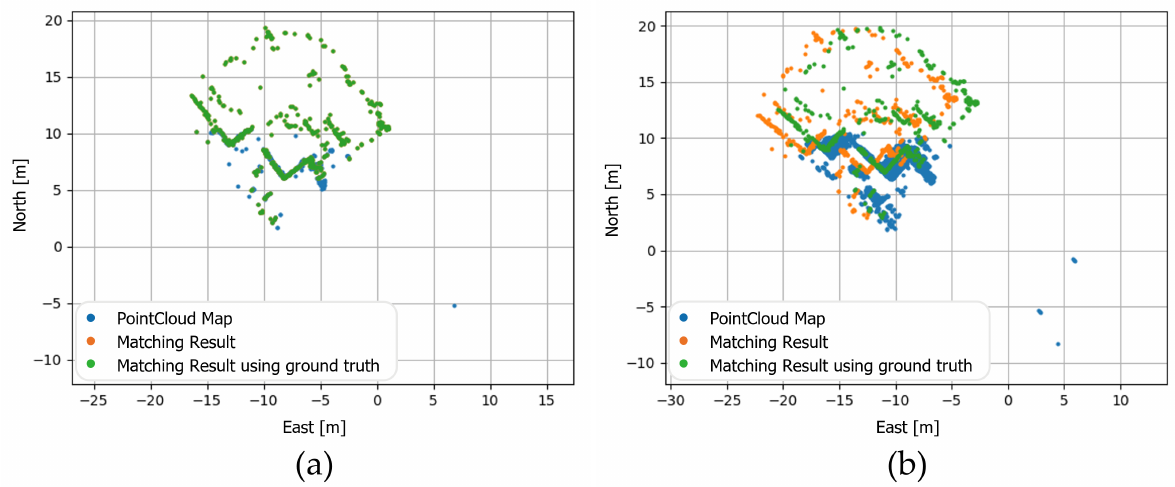
Figure 4. ( a ) Result of matching between PCM and point cloud using the good calibration parameter; ( b ) result of matching using the wrong calibration parameter; blue points represent PCM on world coordinate, orange points represent matched points using registration, and green points represent points that are converted using ground truth LiDAR